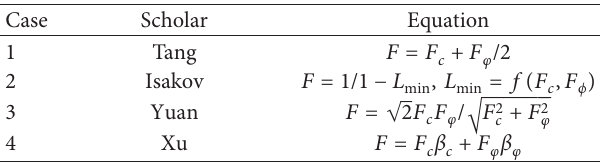
Table 1: Different methods of calculating the comprehensive safety factor [14, 17, 20,